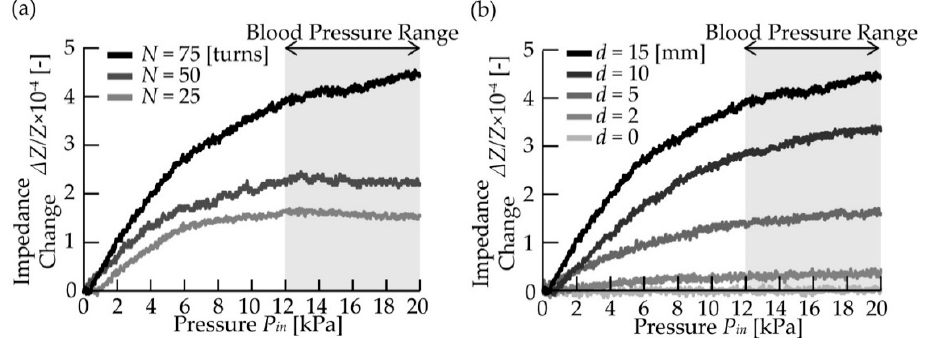
Figure 7. Wireless pressure measurements for evaluating sensor performance. ( a ) The relationship between the applied pressure and the impedance of the receiver coil with different turns. ( b ) The relationship between the applied pressure and the impedance of the receiver coil with different overlapping lengths.